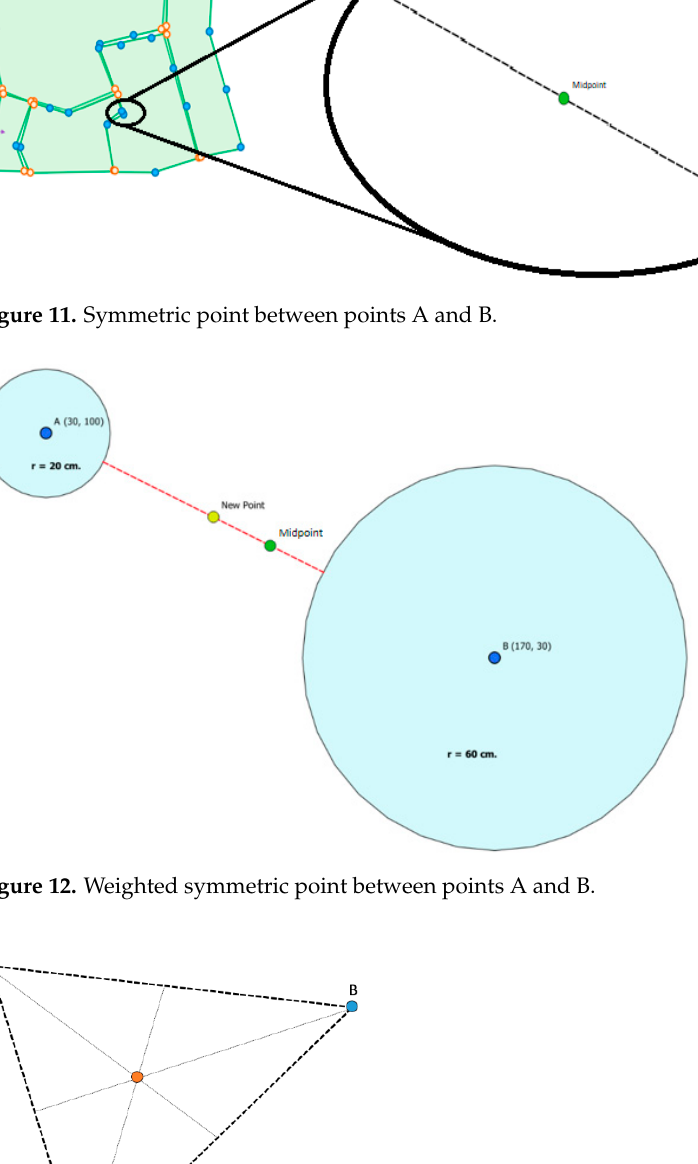
Figure 12. Weighted symmetric point between points A and B.